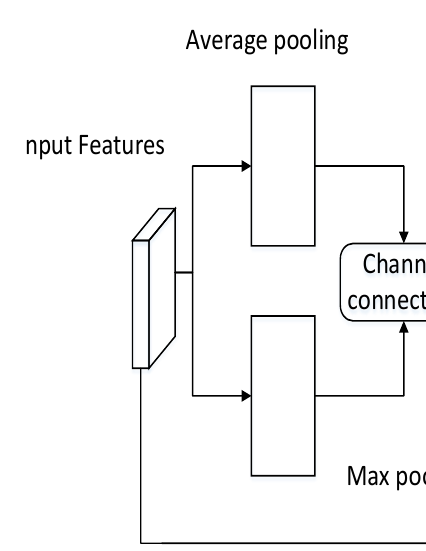
Figure A4. Schematic diagram of spatial attention mechanism.